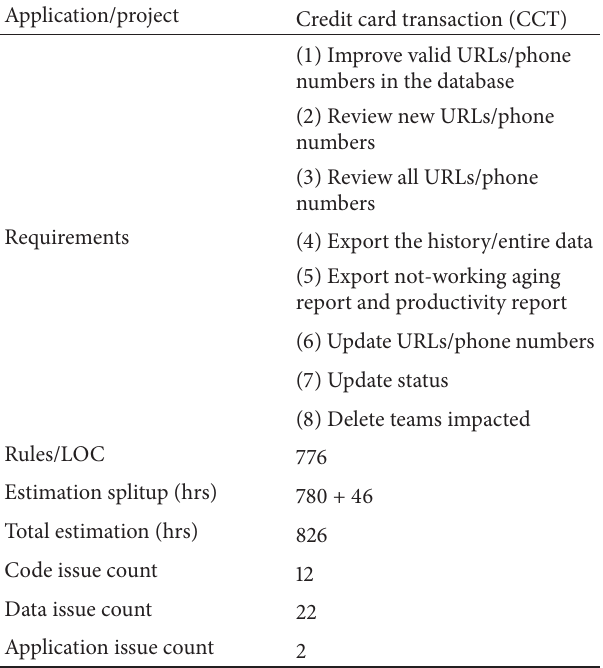
Table 2: Requirements and application issue count reports for the CCT project.